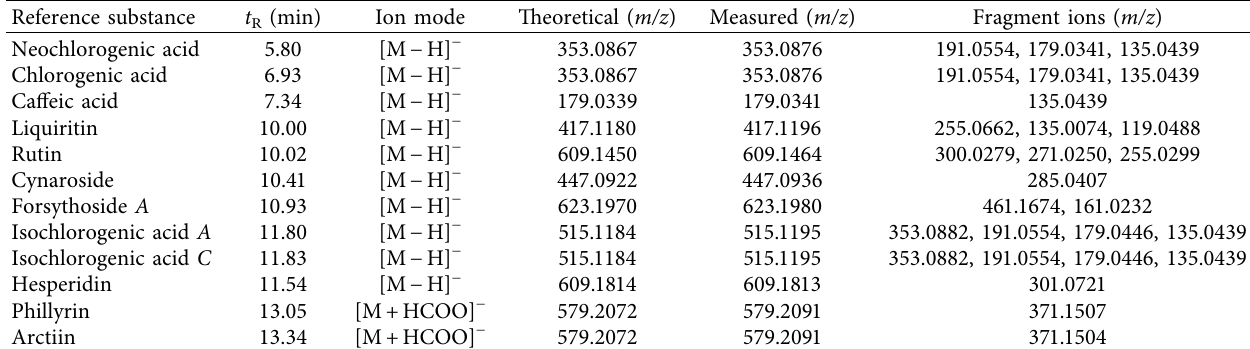
Table 2: Mass spectrometry information of reference substances.